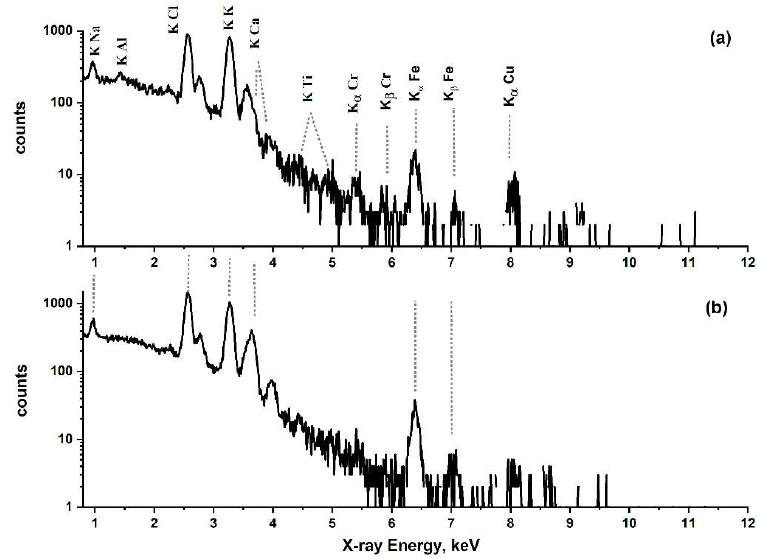
Figure 1. PIXE representative spectra of tears from ( a ) a subject from a rural area, ( b ) a subject from an urban area (both smokers).